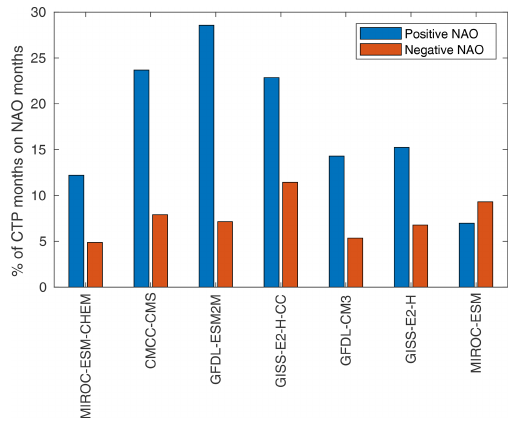
Figure 12. Share of preferably phased RCP8.5 CTP months in the AS domain that occur concurrently with a positive (blue) or negative (red) NAO phase. All models shown are from the AS